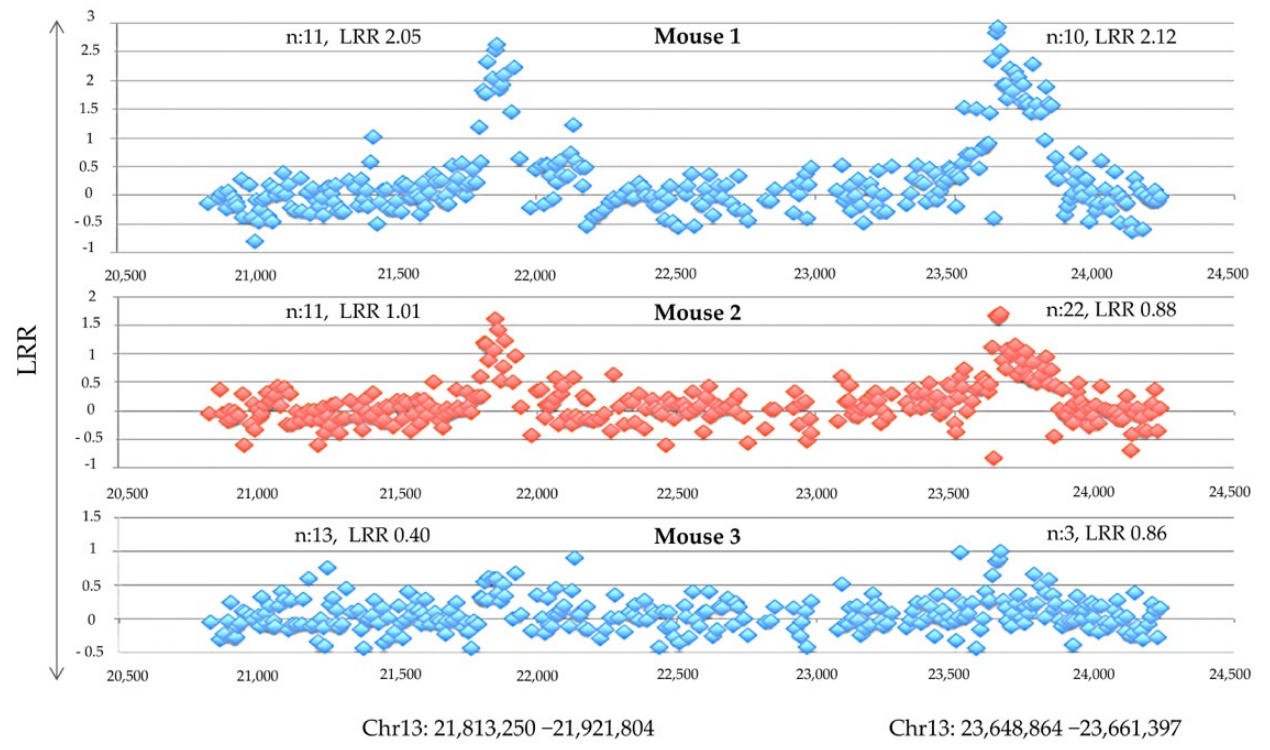
Figure 2. Comparative genomic hybridization (CGH) showing independent recurrent CNAs in memory cells obtained from the pancreatic lymph nodes of three different diabetic mice, spanning two histone families’ loci, collectively referred to as histone H1, H2, and H3, separated by a normal copy-number stretch encoding other genes ( n : number of affected probes, DLRSpread values: Mouse 1: 0.28, Mouse 2: 0.23, and Mouse3: 0.19).